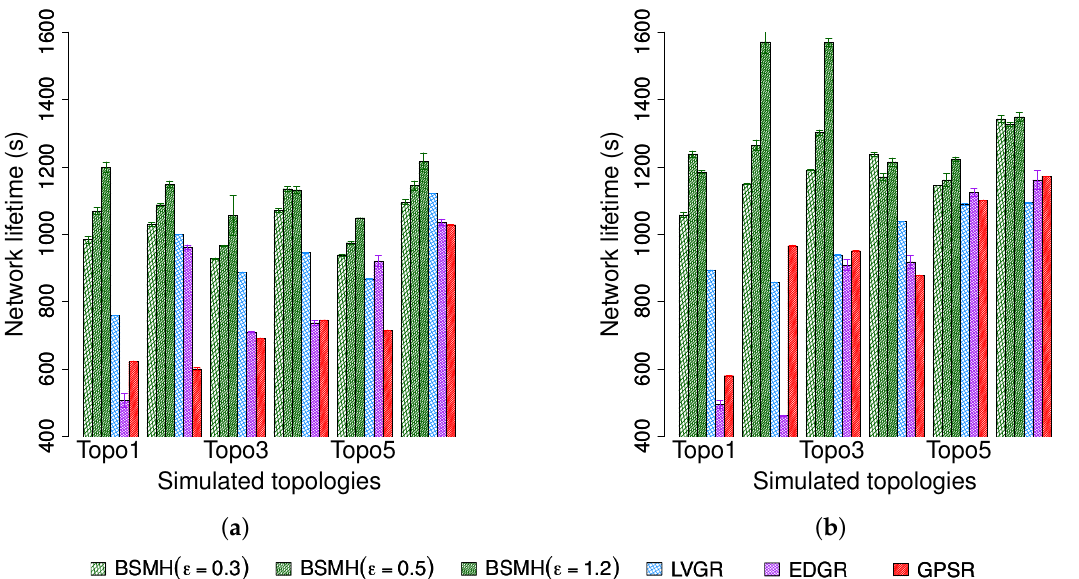
Figure 20. The network lifetime [38]. ( a ) 1-n communication. ( b ) n-n